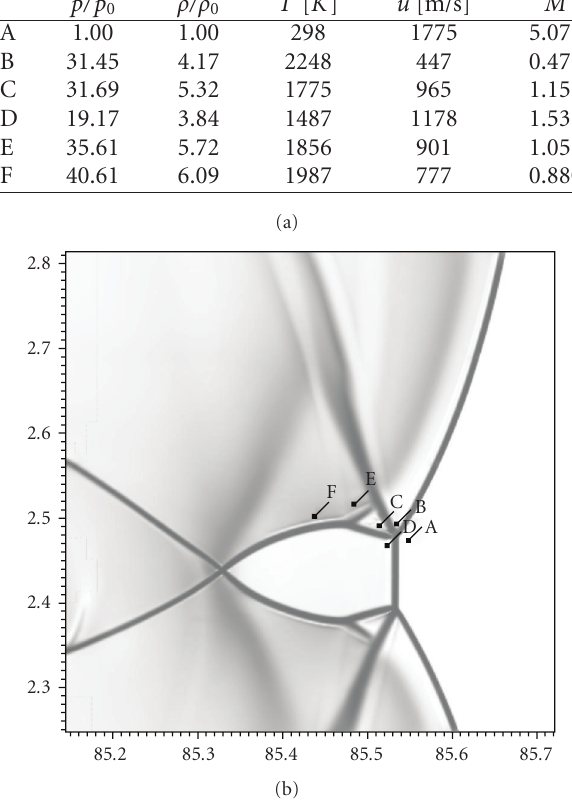
Figure 23: States of a double Mach reflection structure shortly before the next collision in a regularly oscillating CJ detonation in a H 2 :O 2 : Ar/2 :1 :7 mixture at initially 298K and p 0 = 10 kPa.